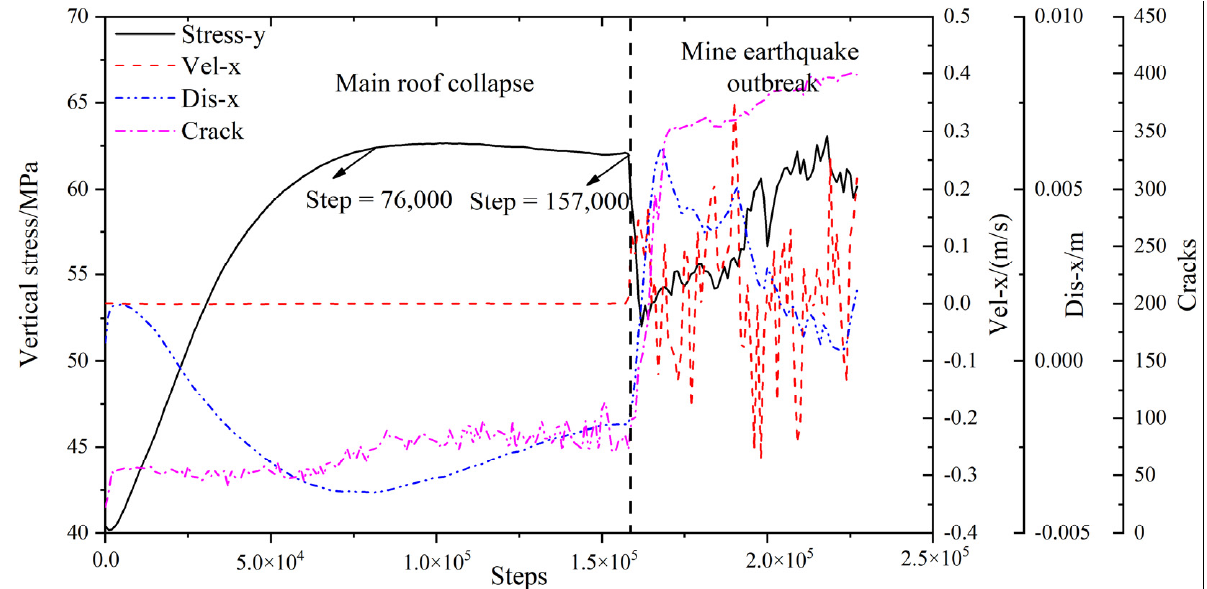
Figure 7. Variation curves of vertical stress, displacement and crack number around the roadway.